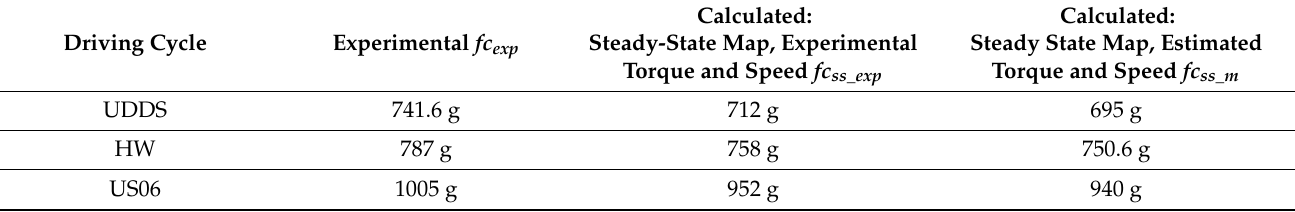
Table 2. Comparison of overall fuel consumption from the model and experiment for the conventional